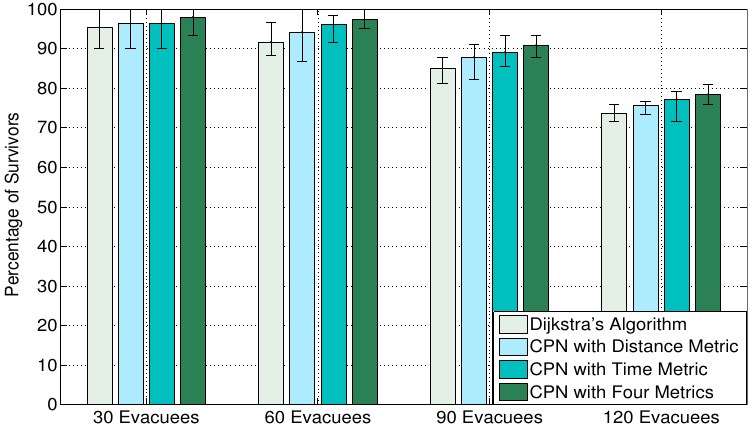
Figure 9. The percentage of survivors for scenarios with heterogeneous evacuees. The results are the average of 10 randomized simulation runs, and the error bars show the min/max result in any of the 10 simulations. “CPN with four metrics” depicts the CPN-based algorithm to route four kinds of evacuees with the related